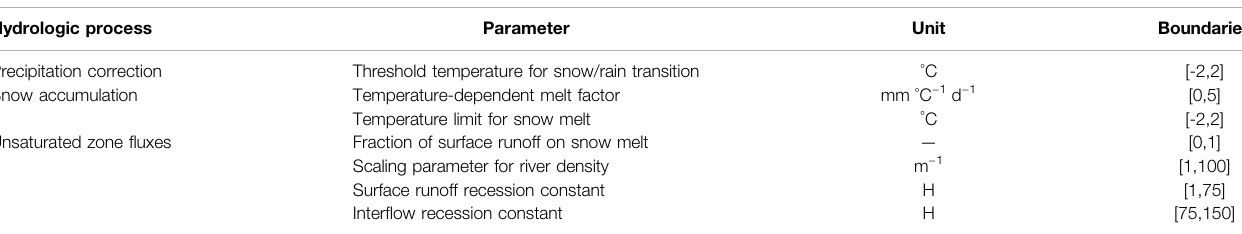
TABLE 4 | Calibration range of WaSiM-ETH free parameters. Hydrologic